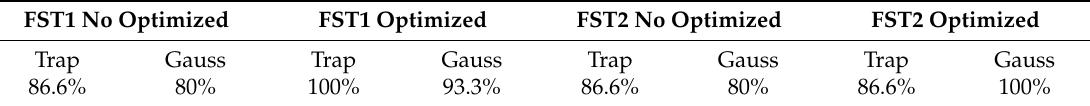
Table 16. Classification with type-1 and interval type-2 fuzzy systems with random patients. FST1 No Optimized